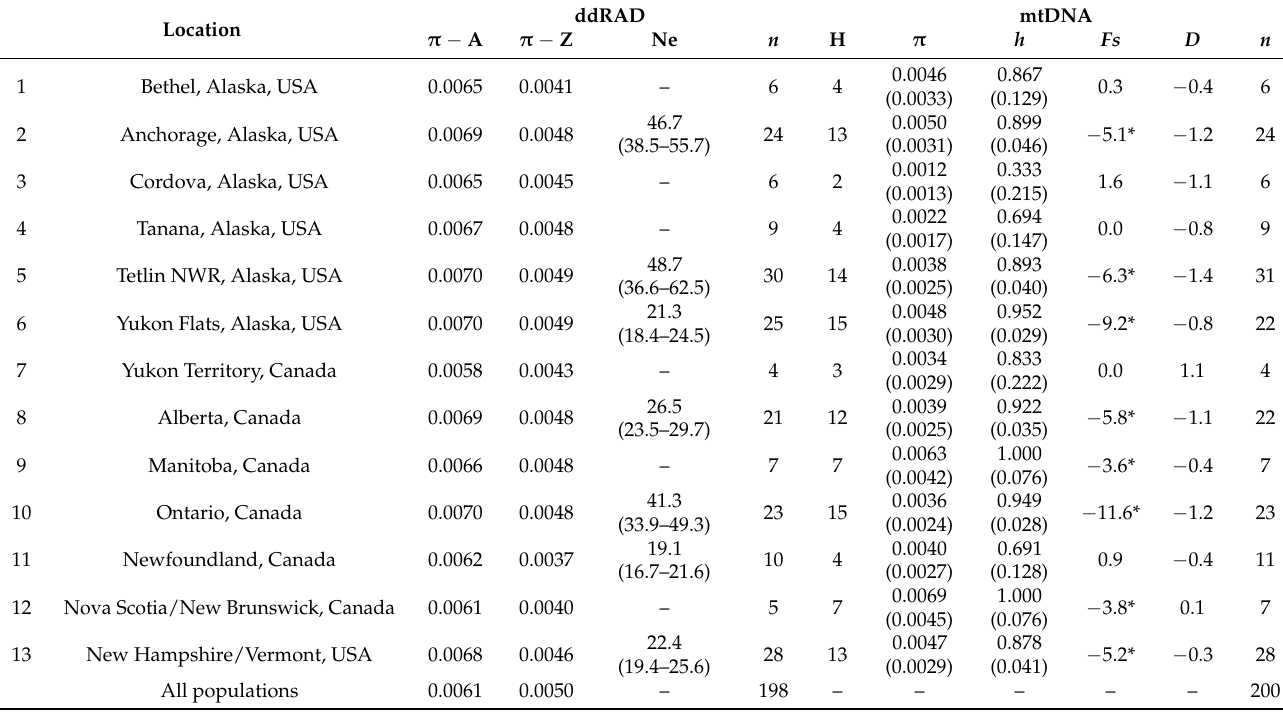
Table 1. Indices of genetic diversity for rusty blackbirds sampled across their North American nesting distribution. Descriptive statistics are listed by marker type (ddRAD autosomal and Z-linked loci, and mtDNA control region) and include nucleotide diversity ( π : autosomal [A], z-linked [Z]), effective population size (Ne) based on the molecular co- ancestry method, number of haplotypes (H), haplotype diversity ( h ) along with sample size ( n ). Locations are listed west to east. Single standard deviation and 95% confidence limits are in parentheses. Significant values are indicated by asterisks. Refer to Figure 1 for location